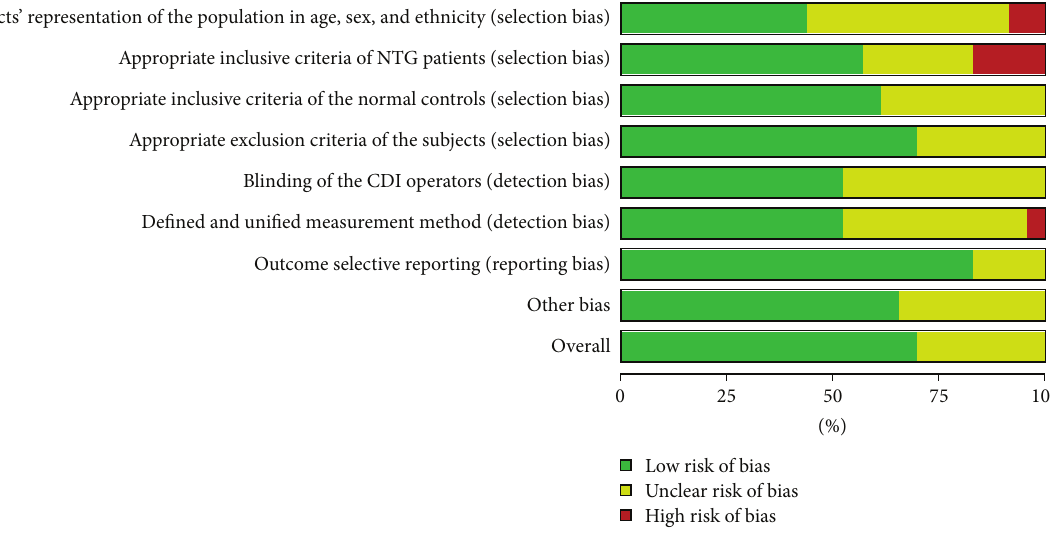
Figure 2: Risk of bias rate of each